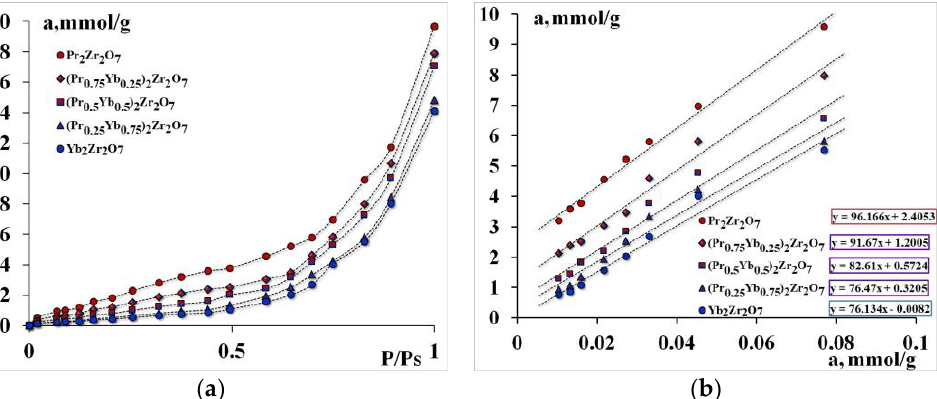
Figure 3. Isotherms of Water adsorption — ( a ), comparative adsorption isotherms at low pressures — ( b